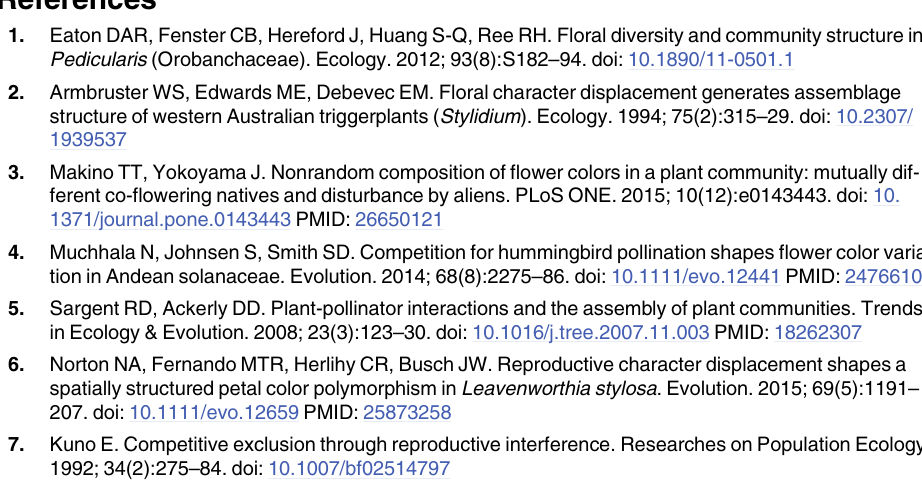
S5 Fig. Effect of density and the relative abundance of non-M-specieson the frequencyof purple morph of M-species. Both the density of non-M-species and relative abundance of non-M-species affected morph frequency of M-species. Generalizedadditive model found sig-